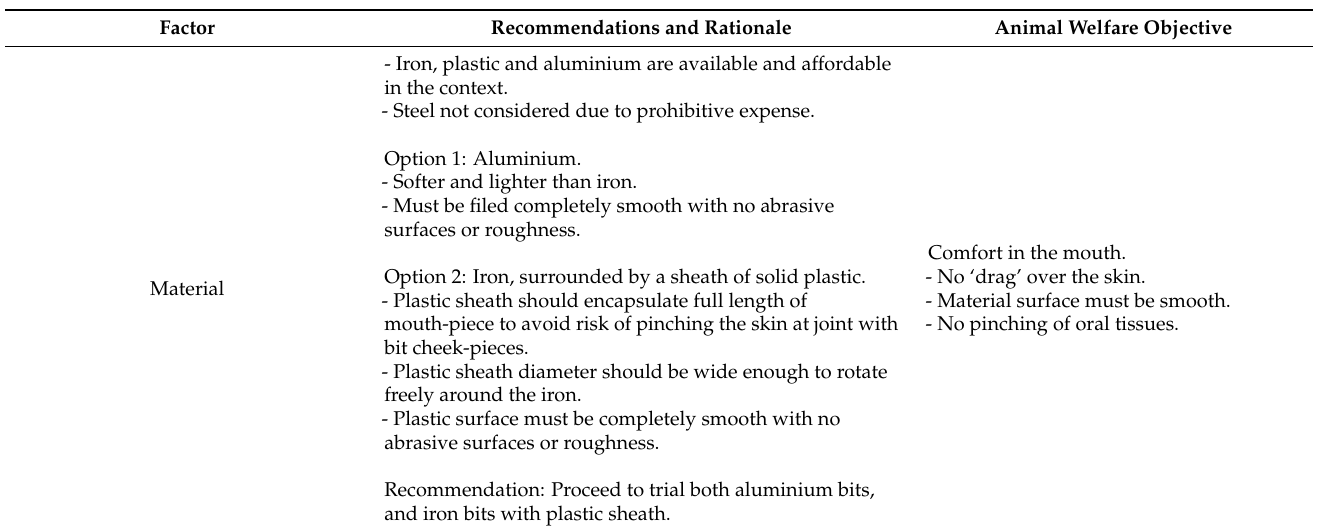
Table 1. Summary of bit specifications. For each factor, the recommendation given to the artisan, its rationale and the animal welfare objective are indicated. Bit images in this table are included to give an indication of type, rather than demonstrate exact designs used in the present study (drawn by Ruth